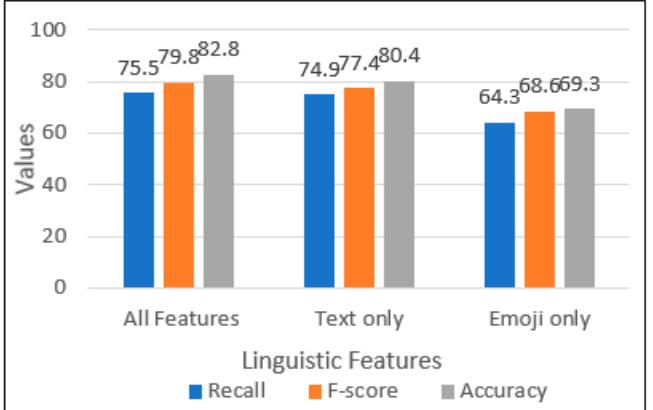
Figure 3. Classifiers relative performance for the proposed approach.